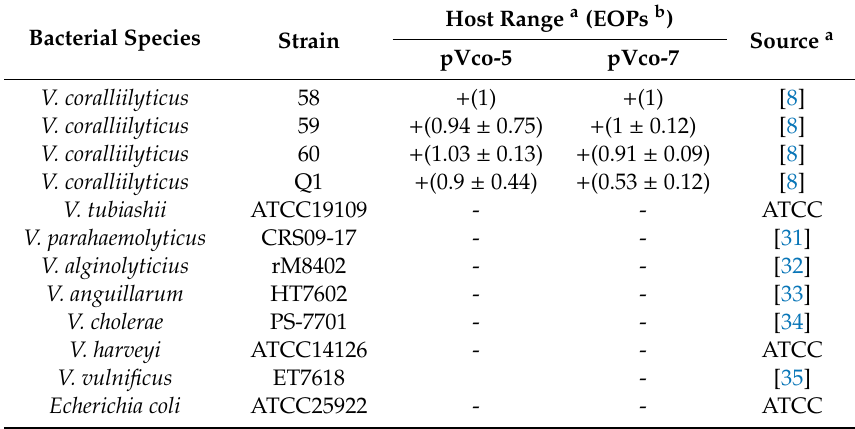
Table 1. Bacterial Strains Used in This Study and Infectivity of Isolated Bacteriophage (Phage) pVco-5 and